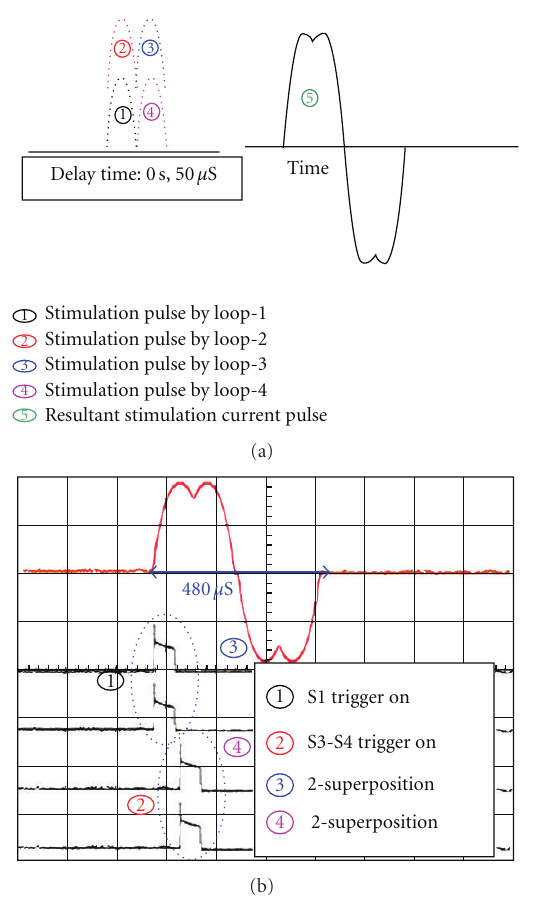
Figure 8: (a) Idea, (b) test. S1, S2 → S3, S4: trigger on (delay: 0s, 50 μ S; pulse width: 480 μ S).